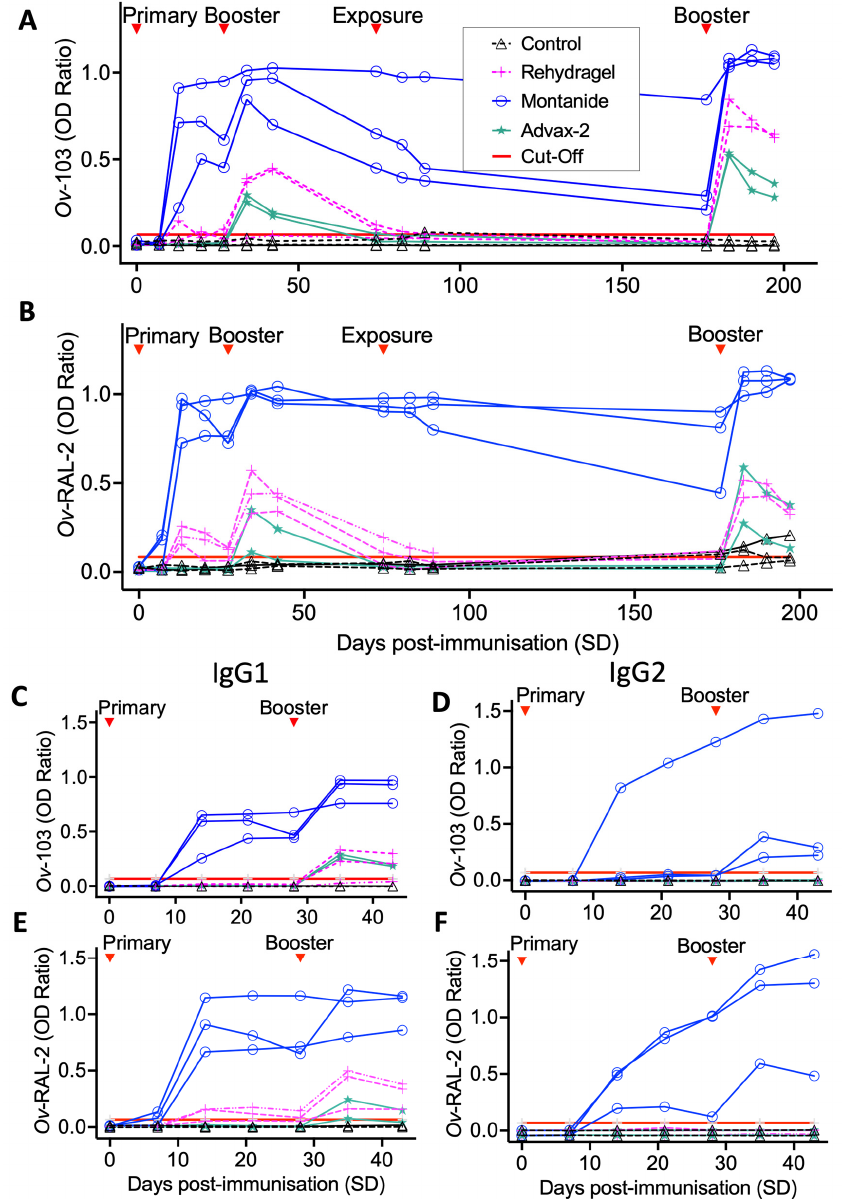
Figure 2. Timeseries of Ov -103 and Ov -RAL2-specific serum IgG responses for three different vaccine formulations and unvaccinated control animals assessed by ELISA (1:800 dilution) from pre-study immunogenicity trial. Relative timing of primary, booster immunisations and natural exposure are denoted for ( A ) anti- Ov -103 total IgG ( B ) anti- Ov -RAL-2 total IgG ( C ) anti- Ov -103 IgG1 ( D ) anti- Ov -103 IgG2 ( E ) anti- Ov -RAL-2 IgG1 ( F ) anti-O v -RAL-2 IgG2. Solid red line denotes each assay’s detection threshold for serum